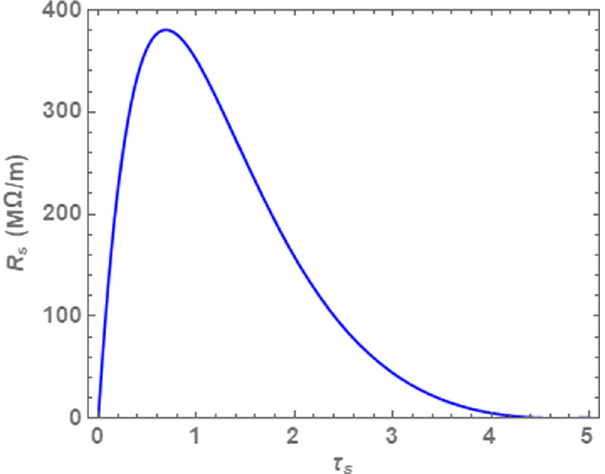
FIG. 11. The shunt impedance per unit length of a CG structure as a function of the section attenuation τ